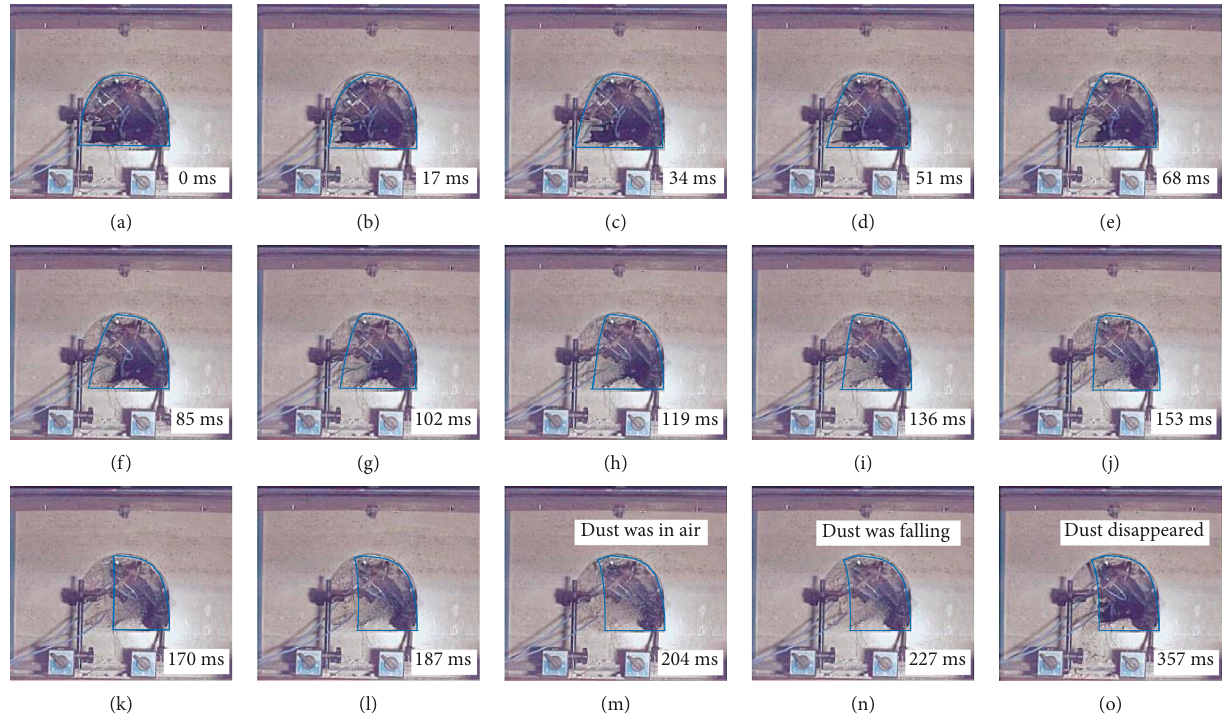
Figure 10: Rockburst failure of the modelled roadway recorded by a high-speed